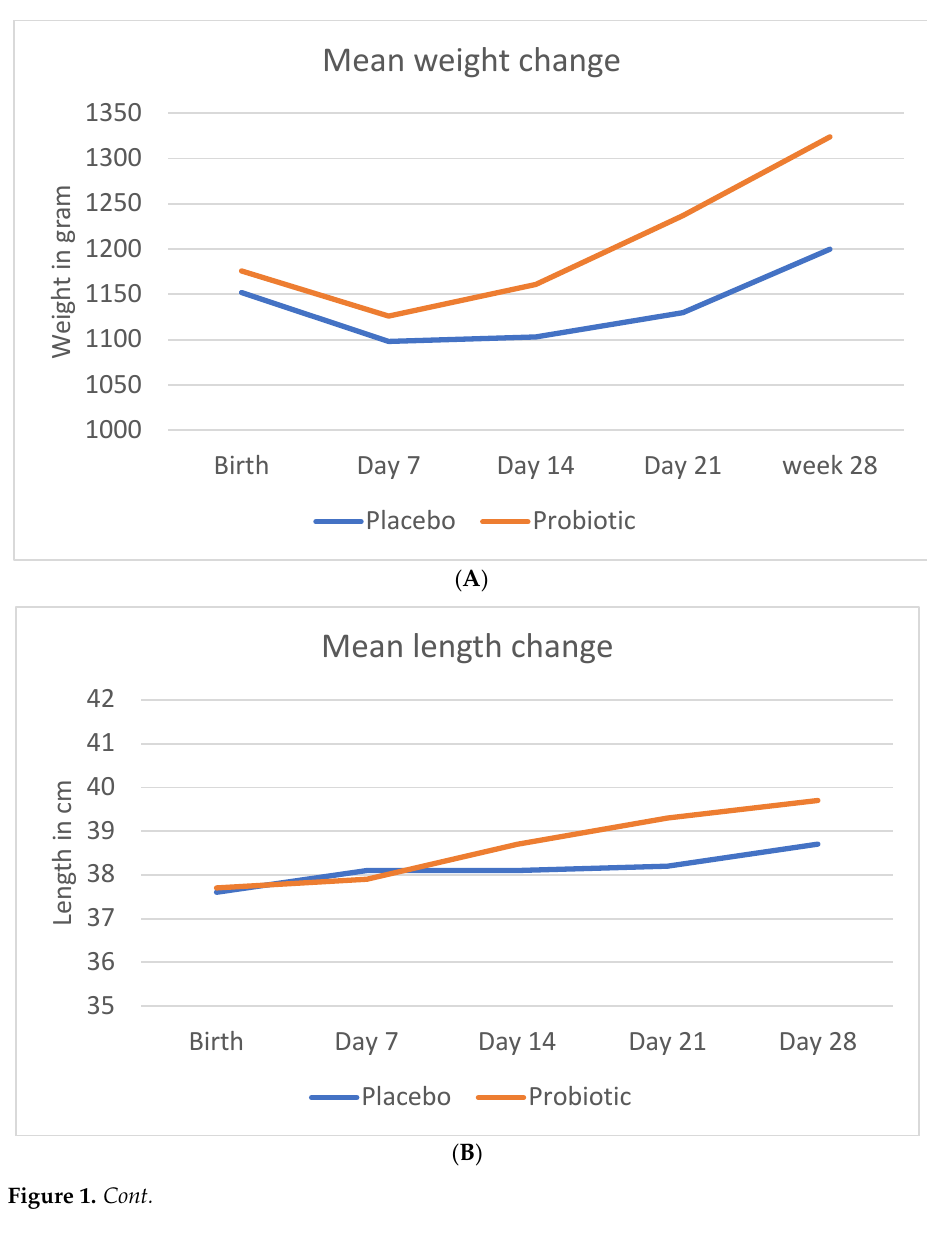
( C ) Figure 1. Change in anthropometric measurements during the study period. ( A ) Mean crude change in weight ( B ) Mean crude change in length ( C ) Mean crude change in head circumference. Table 4 indicates the crude weight, length, and head circumference changes over time and at the different time points. The change in weight over time was statistically signifi ‐ cant in probiotic group, from day 21 onwards. The change in length was statistically sig ‐ nificant only at day 28. There was no statistically significant change in the head circum ‐ ference. Table 4. Change in the crude anthropometric measurements of the neonates over the trial period. Estimated Difference